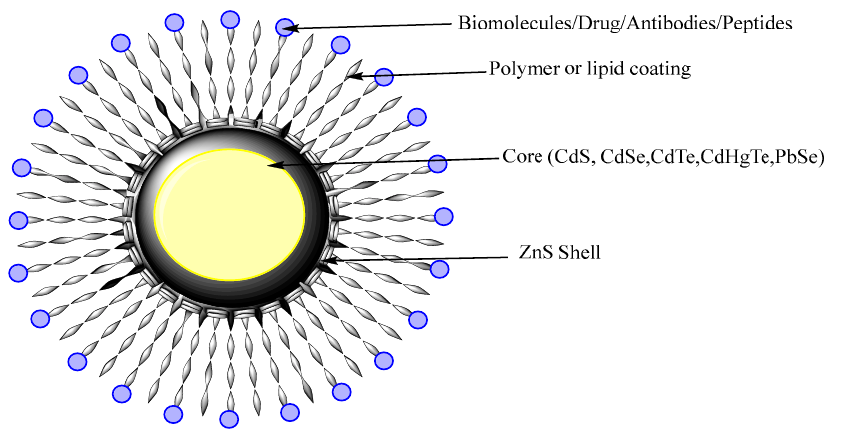
Figure 8. Schematic diagram of QDs. QDs have a core structure of heavy metal that provides fluorescence. The shell stabilizes the core and polymeric coating direct the targeted or active